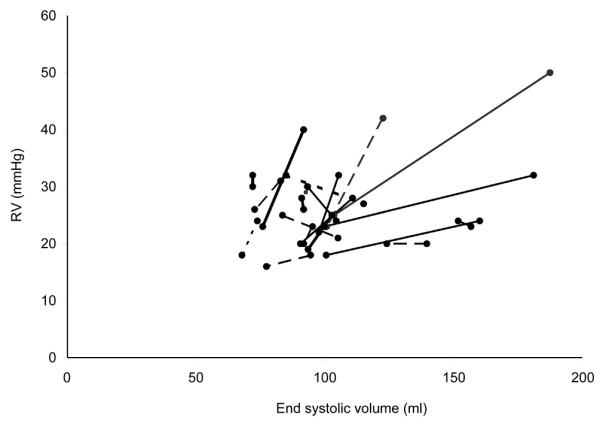
End-systolic pressure–volume relationship. The right ventricular end-systolic pressure (RV) versus the right ventricular end-systolic volume. The end-systolic pressure, and the volume with and without balloon inflation, is connected with a straight line for conventional mechanical ventilation and with the interrupted line for open lung ventilation.